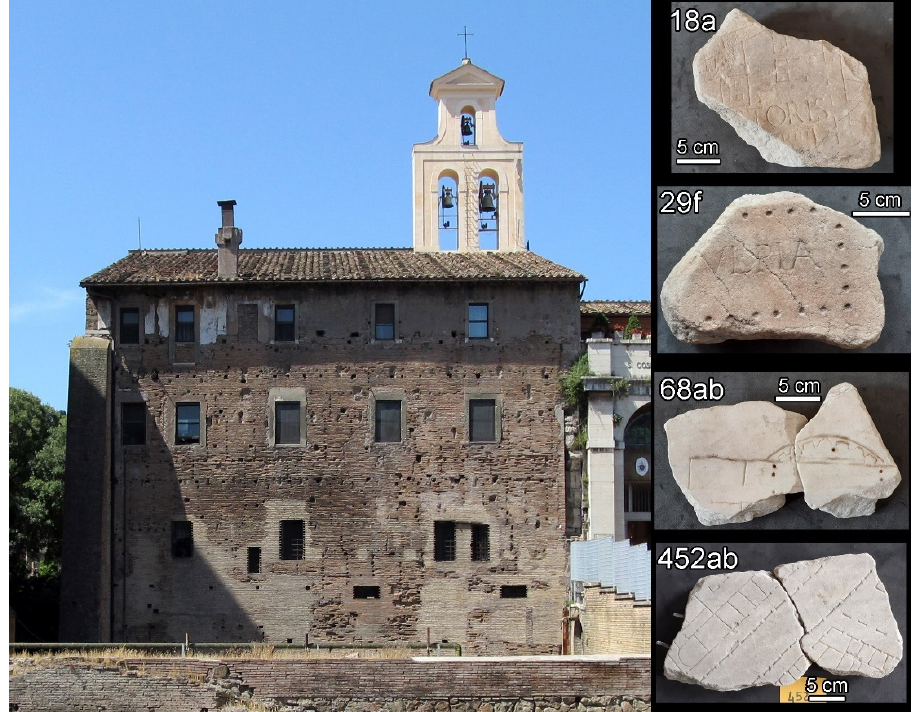
Figure 1. On the left, a view of the present state of the wall of the Templum Pacis , where the Forma Urbis Romae was fixed, currently integrated in the church of Santi Cosma e Damiano . On the right, several examples of sampled fragments of the F.U.